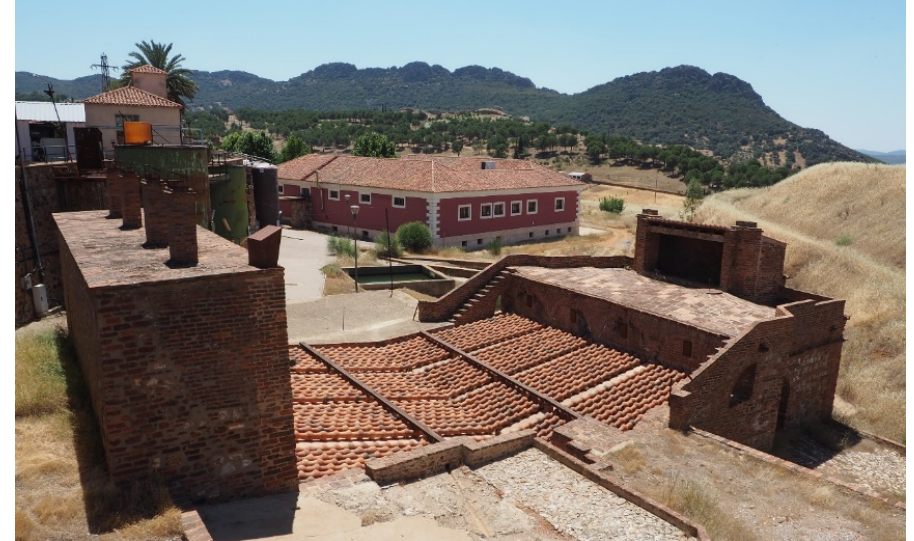
Figure 2. Buildings at the Almadén Mining Park (aludel kilns and Mercury Museum). Source: María del Carmen Cañizares Ruiz